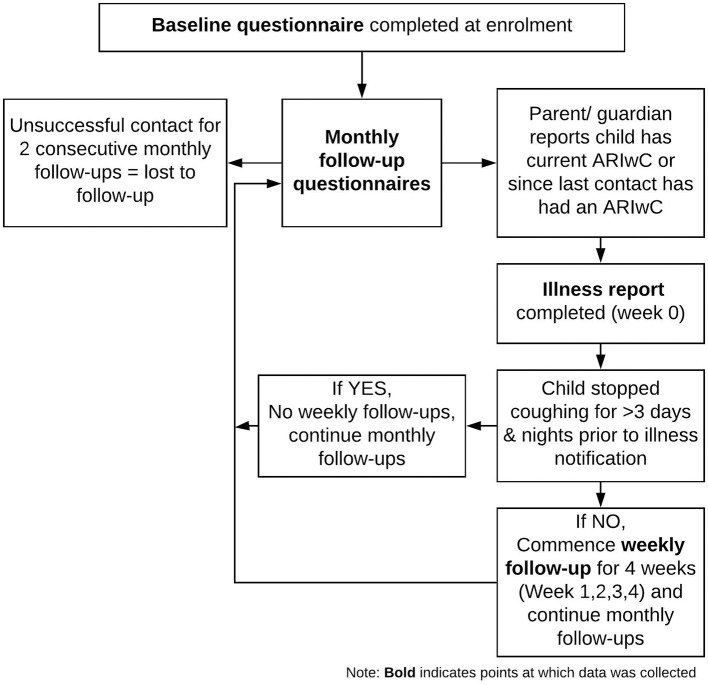
Study procedures.